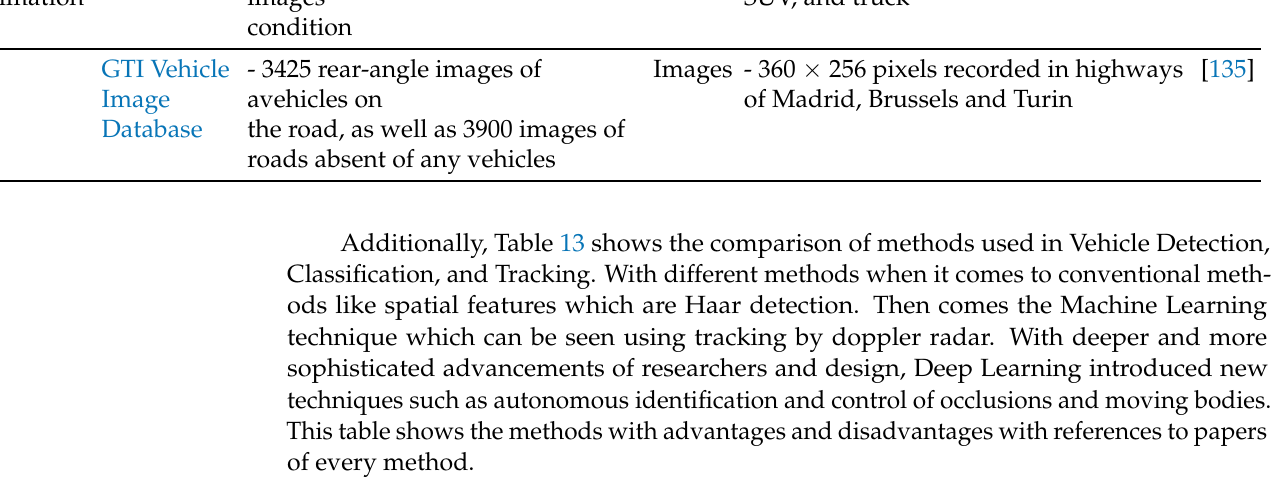
Table 13. Comparison between methods used in